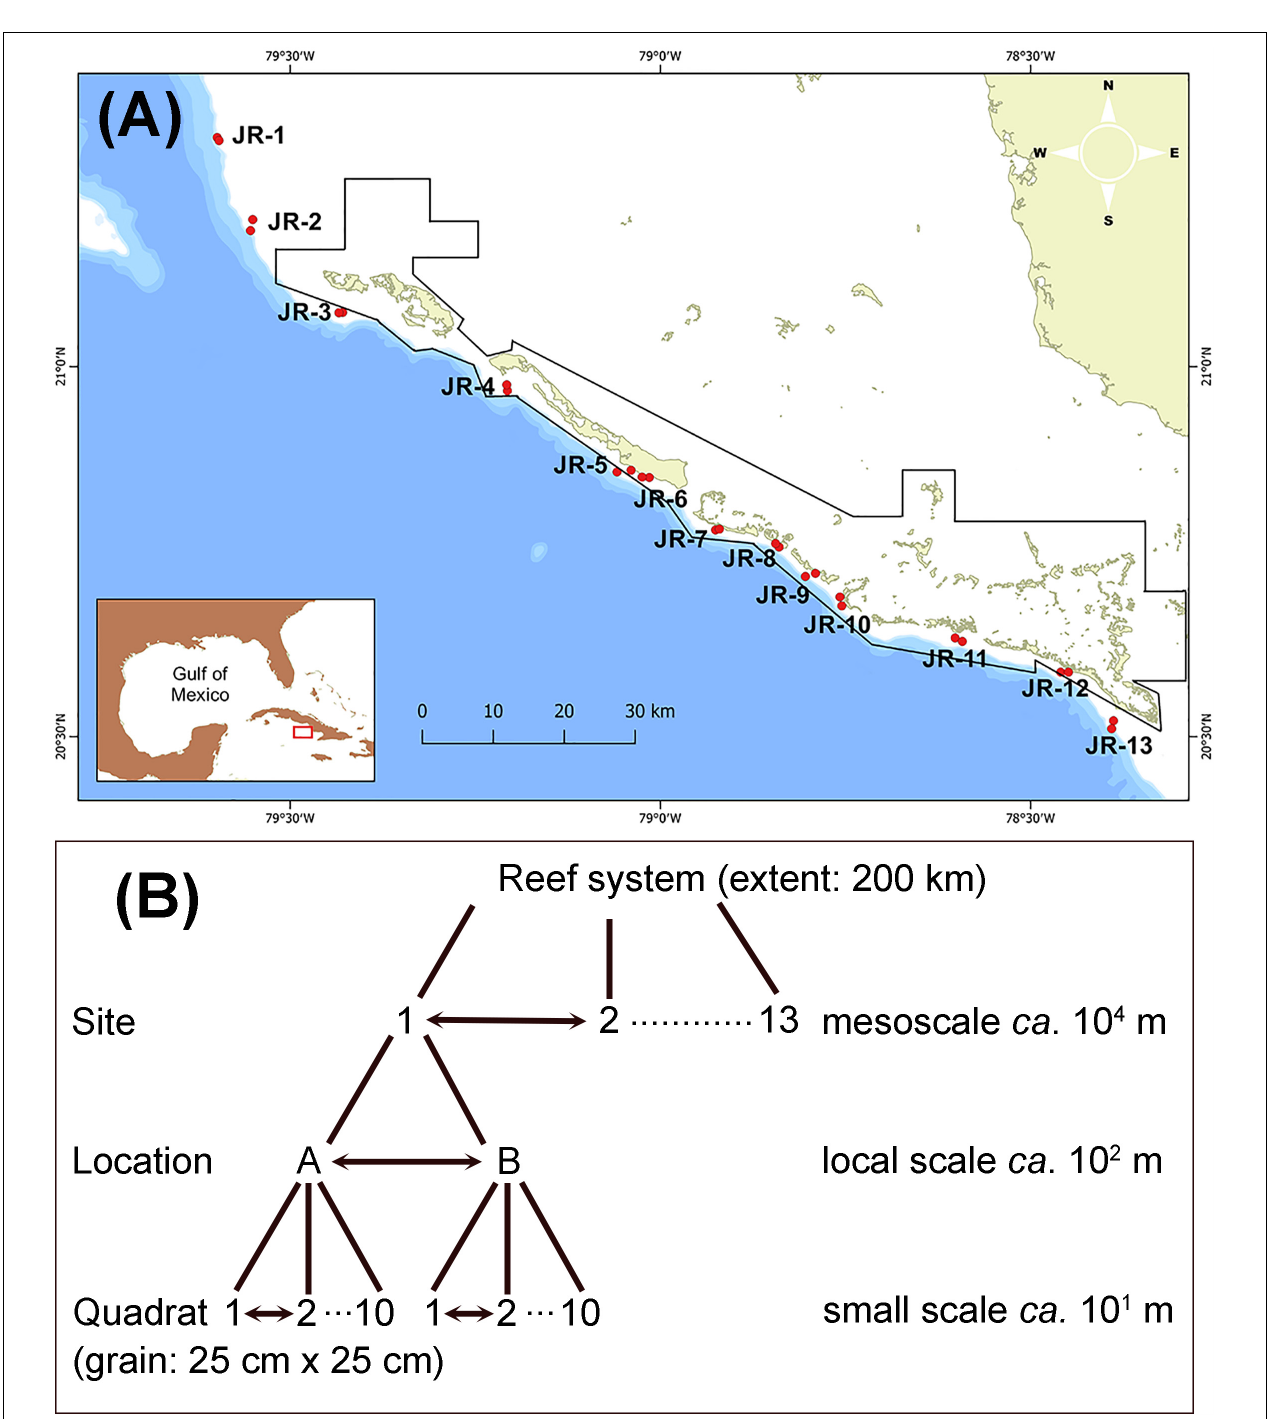
FIGURE 1 | (A) Map of the study zone across the Jardines de la Reina archipelago. Red dots indicate the two sampling locations surveyed at each site (1–13). Black line polygon indicates the limits of the National Park Jardines de La Reina. (B) Scheme of the sampling design showing the hierarchical nested design and the associated spatial